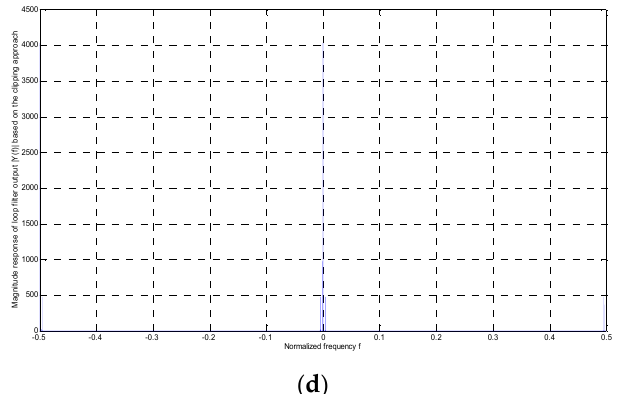
Figure 7. ( a ) Output of the loop filter when u ( k ) = 0.24sin ( 0.0084 π k ) for k ≥ 0 under our proposed control strategy. ( b ) Output of the loop filter when u ( k ) = 0.24sin ( 0.0084 π k ) for k ≥ 0 under the clipping control strategy [7]. ( c ) Magnitude response of the output of the loop filter when u ( k ) = 0.24sin ( 0.0084 π k ) for k ≥ 0 under our proposed control strategy. ( d ) Magnitude response of the output of the loop filter when u ( k ) = 0.24sin ( 0.0084 π k ) for k ≥ 0 under the clipping control strategy [7].